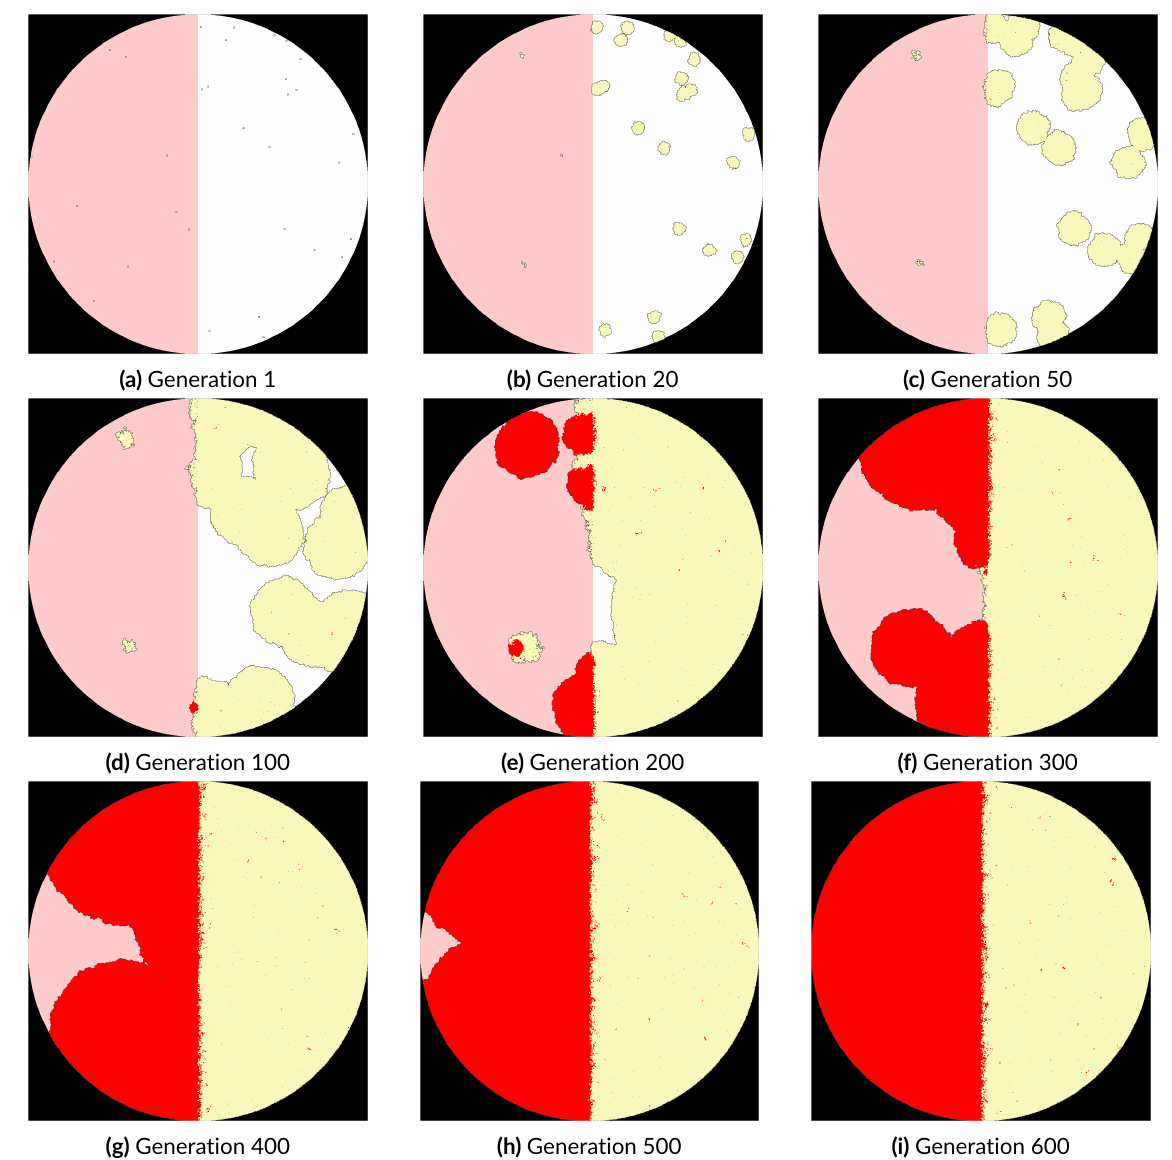
Figure 7 – Representation of the simulated Petri dish at different generations. The pink area represents the half of the dish with antibiotic, while the white half has none. At the first generation, there are 50 colonies (single bacteria) spread randomly on the plate. As the simulation goes forward, we see those colonies growing, in yellow. They grow better in the right-hand half of the plate, due to the absence of antibiotic. Bacteria colored red have acquired antibiotic resistance. We see that the resistant bacteria later grow better in the left half of the dish. Because of the fitness cost of the antibiotic-resistance mutation in the absence of antibiotic, there are only a few red bacteria in the right half at the end of simulation despite their markedly higher mean fitness over the environment as a whole, showing the importance of spatiality for the outcome of the model. The code used to generate this simulation can be found at https://github.com/jeanrjc/BacterialSl imulations